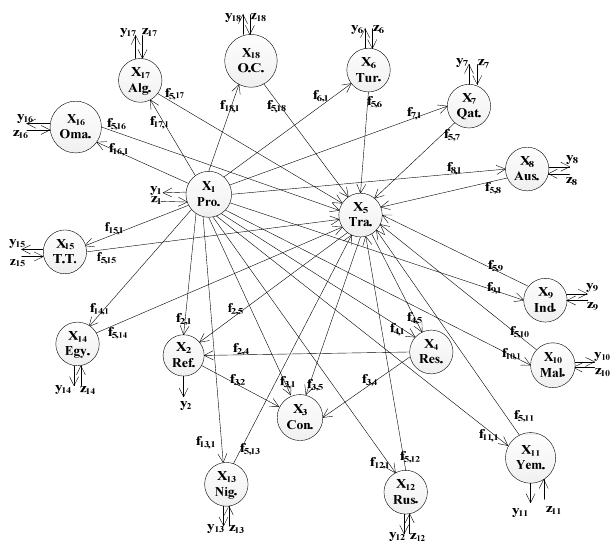
Figure 2. Network model of China’s natural gas supply system on the national layer (NL). X 1 (Pro.): natural gas production sector, X 2 (Ref.): natural gas refining sector, X 3 (Con.): natural gas consumption sector, X 4 (Res.): natural gas reserve sector, X 5 (Tra.): natural gas transit sector, X 6 (Tur.): Turkmenistan, X 7 (Qat.): Qatar, X 8 (Aus.): Australia, X 9 (Ind.): Indonesia, X 10 (Mal.): Malaysia, X 11 (Yem.): Yemen, X 12 (Rus.): the Russian Federation, X 13 (Nig.): Nigeria, X 14 (Egy.): Egypt, X 15 (T.T.): Trinidad and Tobago, X 16 (Oma.): Oman, X 17 (Alg.): Algeria, X 18 (O.C.): other countries, f ij : flow from node j to node i , z i : flow into node i from outside the network, y j : flow out of the network from node j .